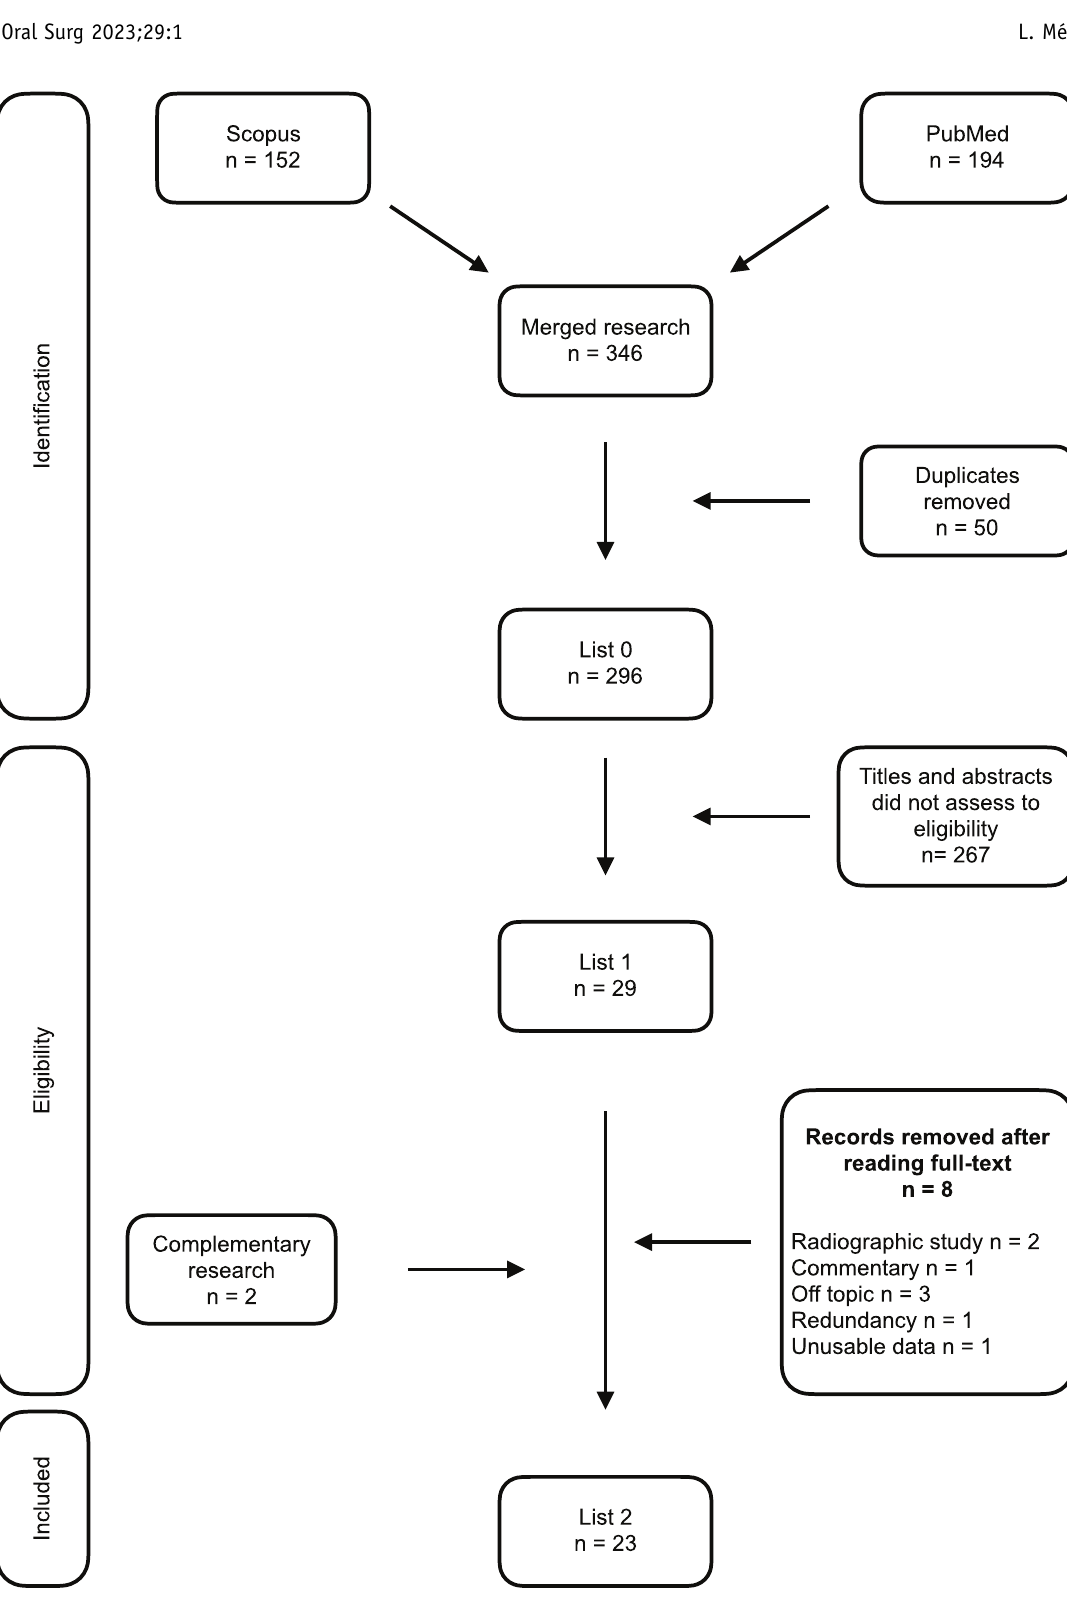
Fig. 1. Flow diagram of the screened